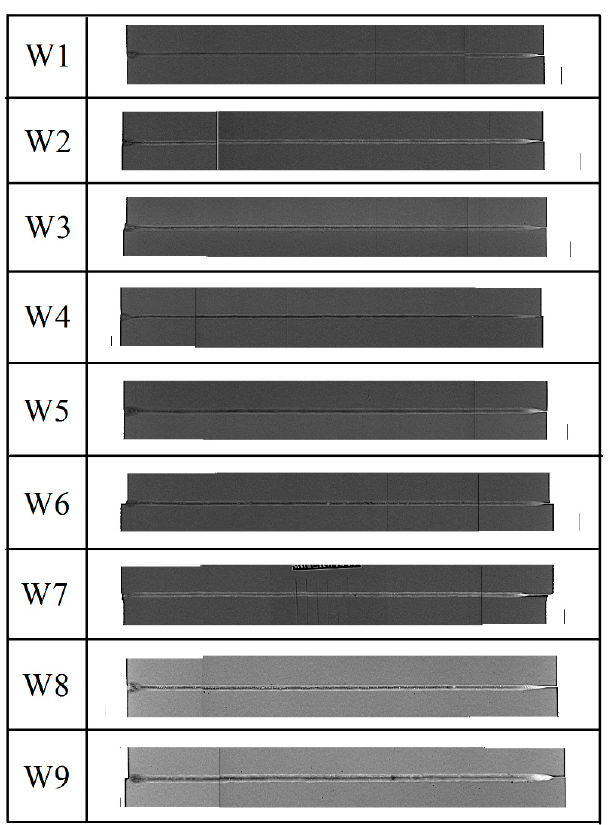
Figure 3. Images of the laser-welded TC31 joints in X-ray detection.